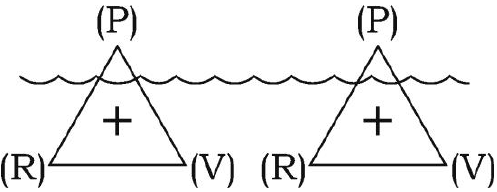
Figure 7: The Submerged Compassion Triangles The Psychological Level Drama Triangles